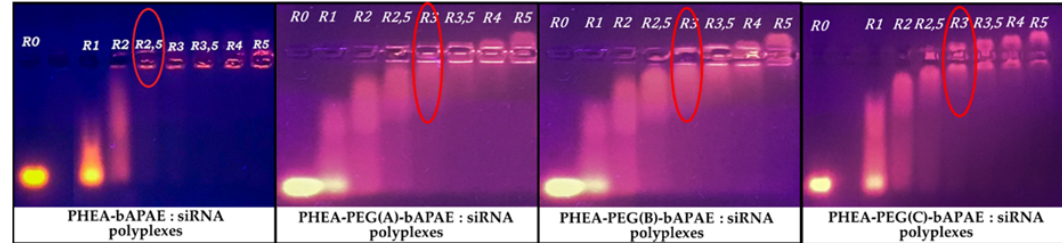
Figure 10. Agarose gel electrophoresis of polyplexes obtained in HEPES 10 mM at various graft copolymer to siRNA weight ratios (R) ranging between 1 and 5.